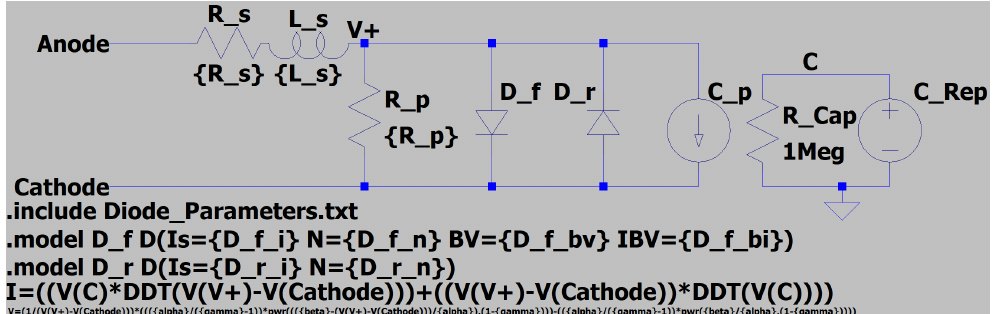
Figure 12. The LTspice implementation of the full circuital model.